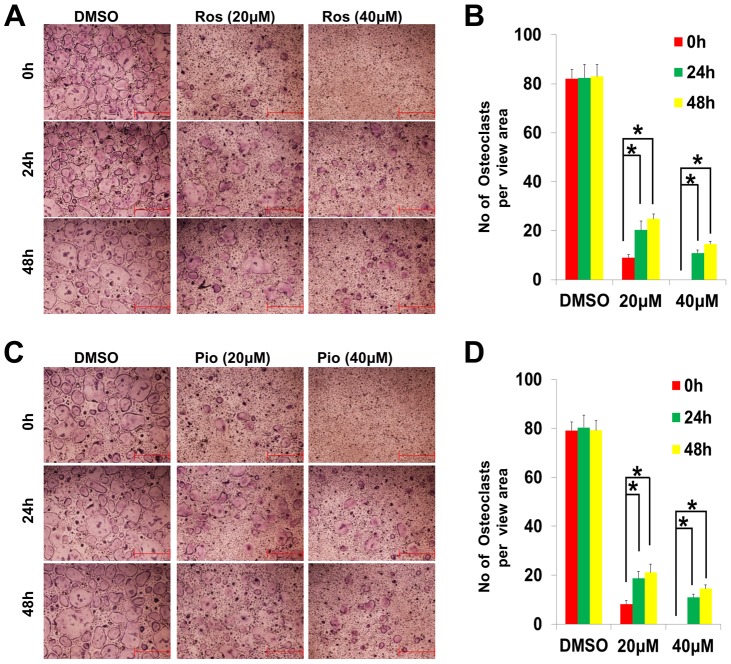
The inhibitory effects of rosiglitazone and pioglitazone on osteoclastogenesis are significantly decreased in RANKL-pretreated BMMs.(A) BMMs were cultured with M-CSF (220 ng/ml) until 30–40% confluence. Then, BMMs were treated with M-CSF (44 ng/ml) and RNAKL (100 ng/ml) for 4 days to stimulate osteoclastogenesis. Vehicle (DMSO), 20 µM or 40 µM of rosiglitazone (Ros) was added at the beginning of the assays (0 hour – 0 h) or 24 h and 48 h after the start of the assays. The cultures were stained for TRAP activity. All assays were performed in triplicate and repeated 3 times and one representative view from each condition is shown. (B) Quantification of the osteoclastogenesis assays in A. The number of multinucleated TRAP-positive cells (>3nuclei) per representative view area at 40× magnification was obtained. Bars show averages of three replicates ±S.D. *P<0.05. (C) The same set of assays in A was performed with pioglitazone (Pio). (D) The osteoclastogenesis assays in C were quantified as described in B. *P<0.05.